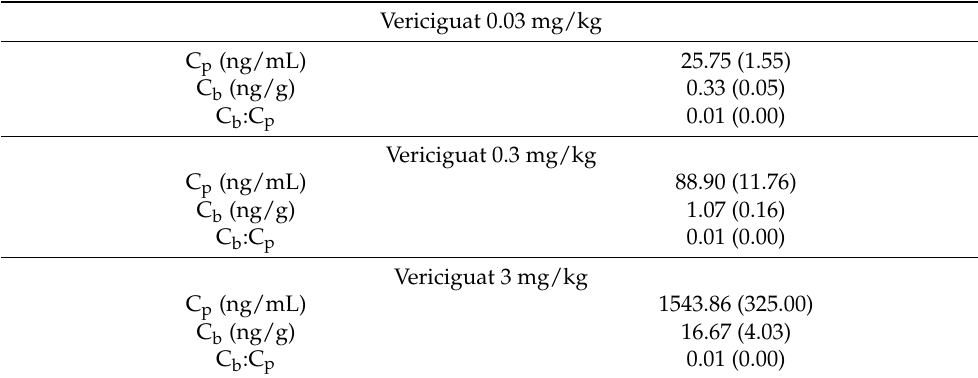
Table 3. Pharmacokinetics of